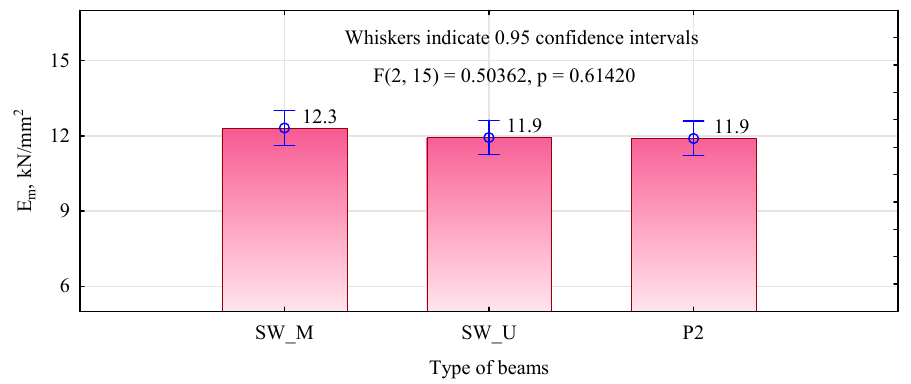
Figure 12. Analysis of the elasticity modulus ANOVA of manufactured 8-layer beams.